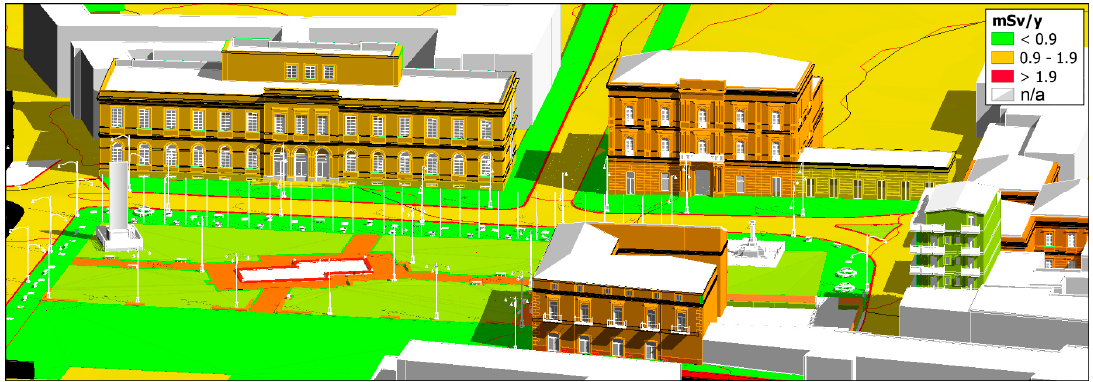
Figure 4. Pompei, Bartolo Longo Square. CIM axonometric view, towards south side, categorized with Yearly Equivalent Dose proceeding from flooring building materials.